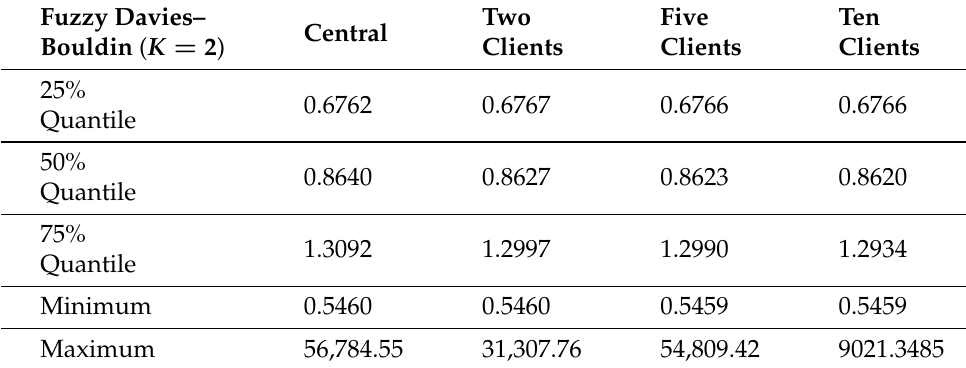
Table 5. Statistics of the (federated) fuzzy Davies–Bouldin index on 100 G2 test sets with federated av- eraging.